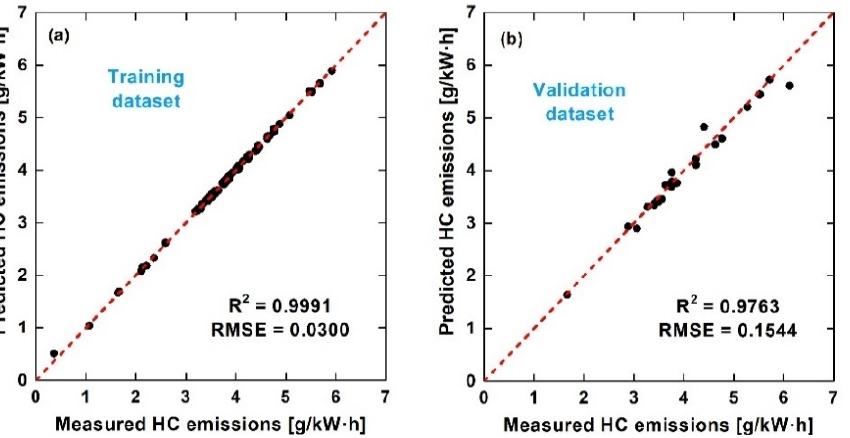
Figure 6. Comparison of SVR predicted results with measured data of HC emissions. ( a ) Training dataset; ( b ) Validation dataset.